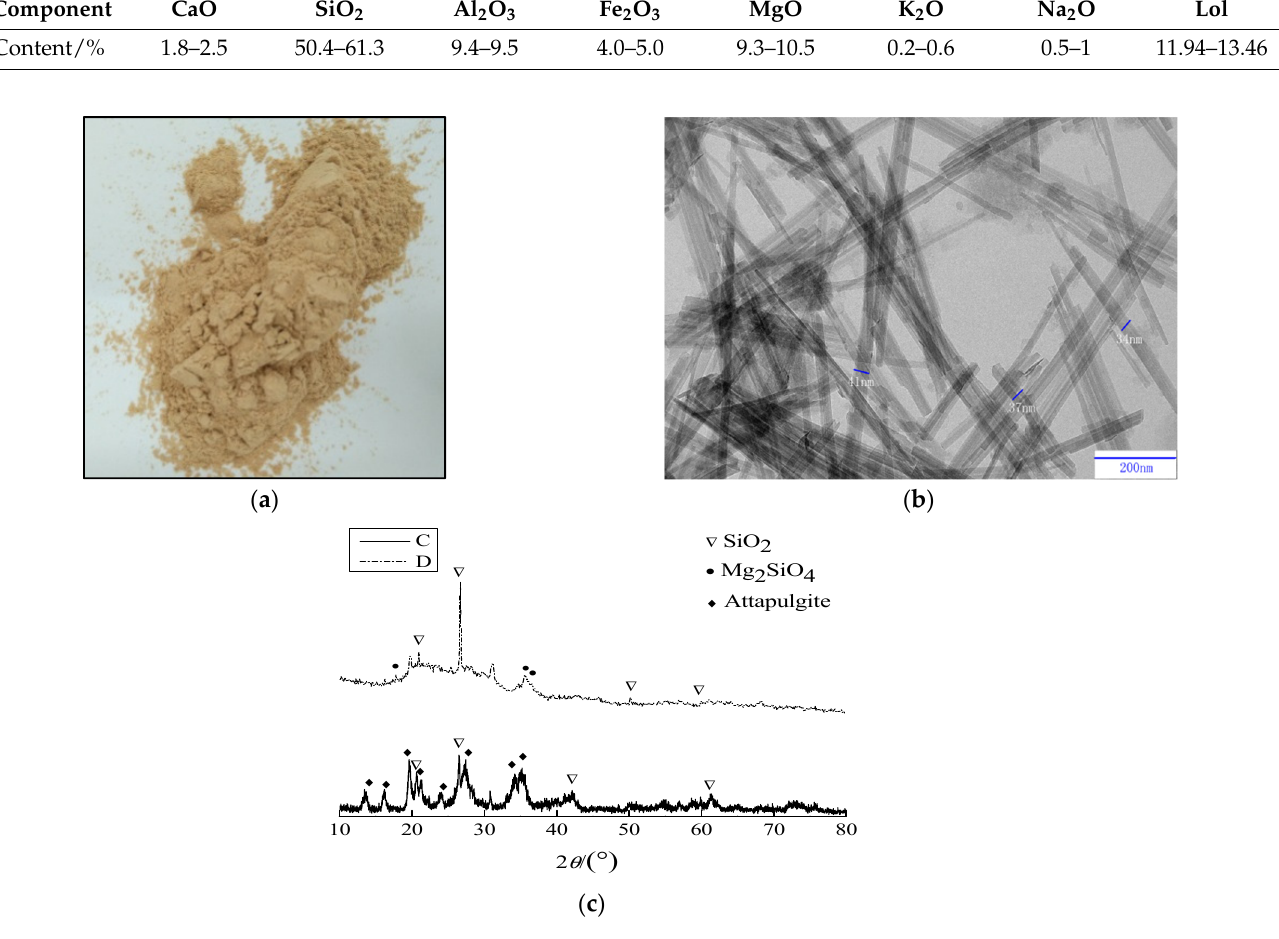
Figure 1. Appearance/TEM/XRD of NAC. ( a ) Appearance; ( b ) TEM; (c) XRD. Table 1. Composition of NAC.